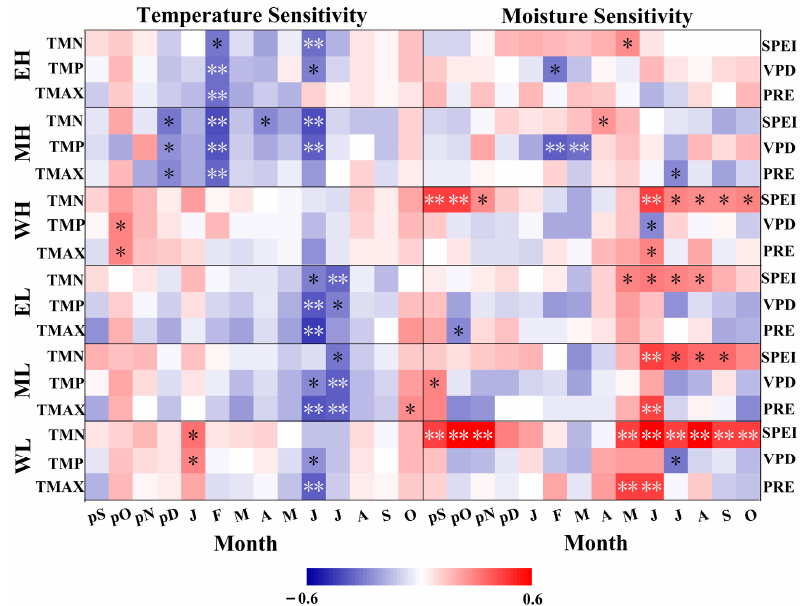
Figure 9. Correlations between TRW and climate factors from September of the previous year to October of the current year in the Qilian Mountain regions from 1960 to 2020. ** p < 0.01; * p < 0.05. Finally, we investigated the relationship between TRW, EVI and climate factors in the whole Qilian Mountain region by redundancy analysis (RDA) (Figure 10). SPEI was the driving factor affecting both TRW and EVI in the low elevation regions. The contribution of SPEI to TRW at low elevation was 10.9%, the contribution of TMAX to TRW at high elevation was 73.2%, the contribution of SPEI to EVI at low elevation was 74.2% and the contribution of VPD to EVI was 11.7%. Therefore, we assumed that the greater the drought intensity, the more consistent the driving factors affecting TRW and EVI were. Compared to low elevation, tree growth at high elevation in the Qilian Mountains is influenced by many factors; temperature is one of the factors affecting tree growth at high elevation in the Qilian Mountains.